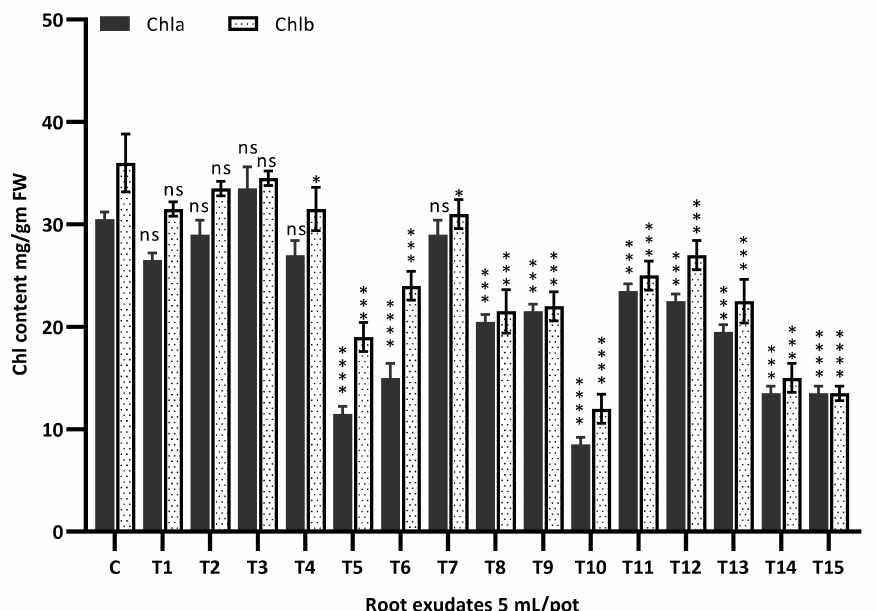
Figure 3. Effects of root exudates on chlorophyll a and chlorophyll b of T. aestivum shoot in pot cultivation. Different numbers of signs (*) indicate significant differences among the different root exudates of the tested weeds at the p < 0.05 level. ns = not significant. C = Control, T1: Centella asiatica , T2: Rotala indica , T3: Solanum nigrum , T4: ommelina benghalensis , T5: Marsilea quadrifolia , T6: Ageratum conyzoides , T7: Cynodon dactylon, T8: Spilanthes acmella, T9: Heliotropium indicum, T10: Leucas aspera , T11: Phyllanthus niruri , T12: Sida acuta , T13: Mikania micrantha , T14: Polygonum hydropiper , T15: Physalis heterophylla